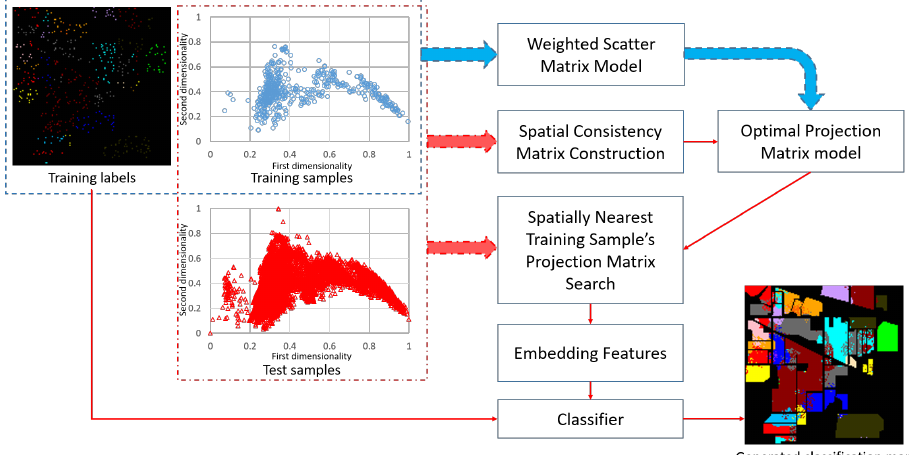
Figure 1. Flowchart of the proposed LWDA method. With a partition factor τ , the training and test sample set (shown in two-dimensional space), as well as the training label set, are obtained. Then, the dataset is used to construct the weighted scatter matrix model, spatial consistency matrix, and optimal projection matrix for each training sample. The next step is to find the spatially nearest training sample’s projection matrix, which is applied to construct the embedding features of training samples and input test sample. Once all the predicted test labels are obtained, the classification map (including the training labels), is generated by exploiting a fixed